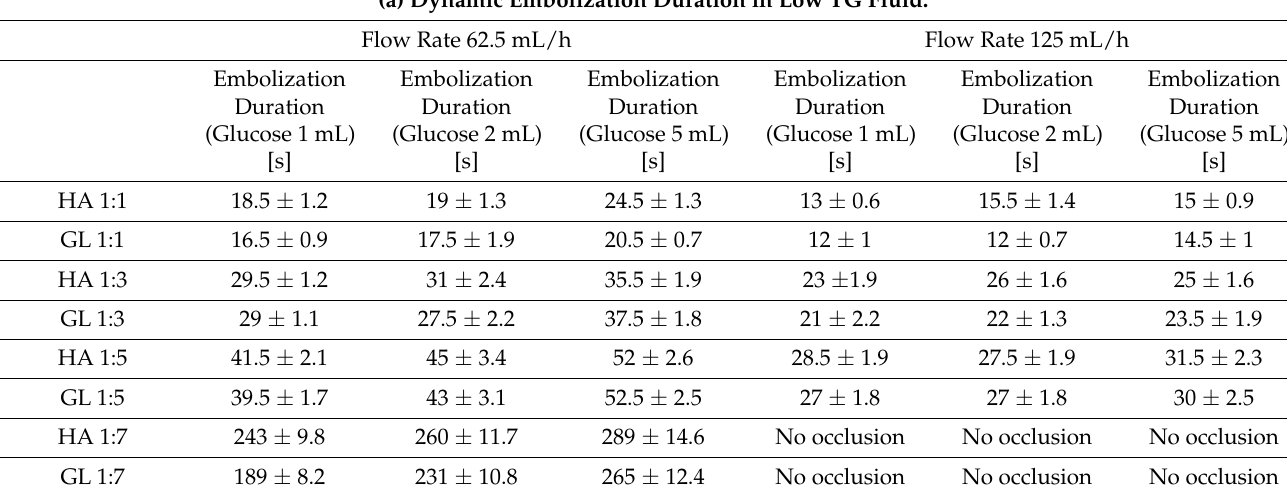
Table 1. Embolization time. (a) Dynamic Embolization Duration in Low TG